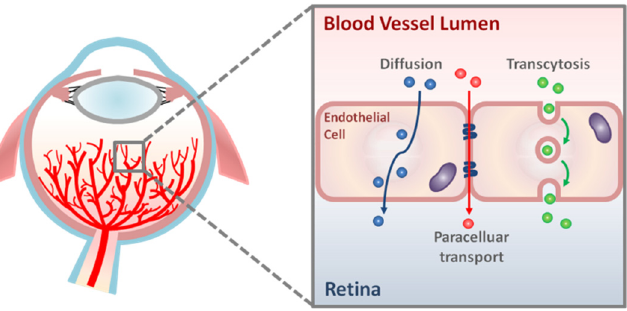
Figure 1. Schematic representation of transport pathways across the retinal vascular endothelium. There are two main routes of molecular transport across retinal vascular endothelial cells: paracellular transport and transcellular transport (diffusion and transcytosis).